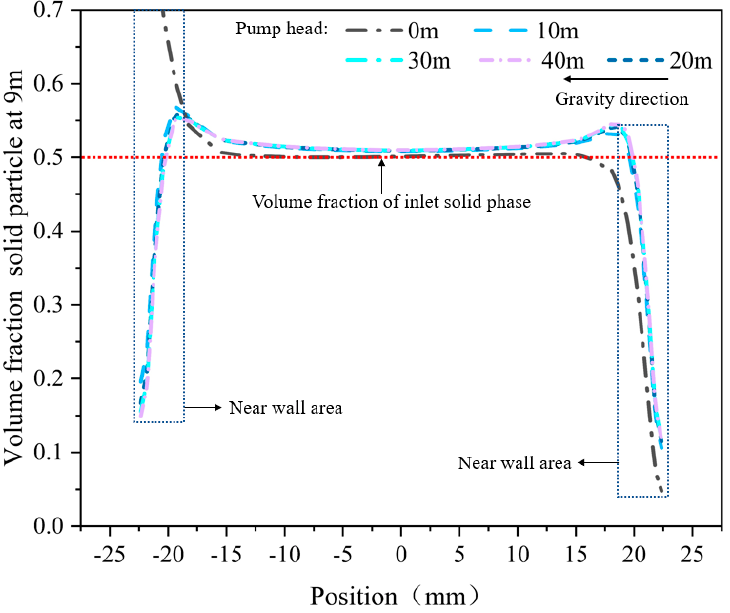
Figure 11. E ff ect of lift head change on solid particle migration Figure 11. Effect of lift head change on solid particle migration process.